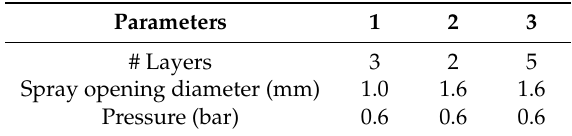
Table 3. Parameter combinations for the pneumatic spray coating process.